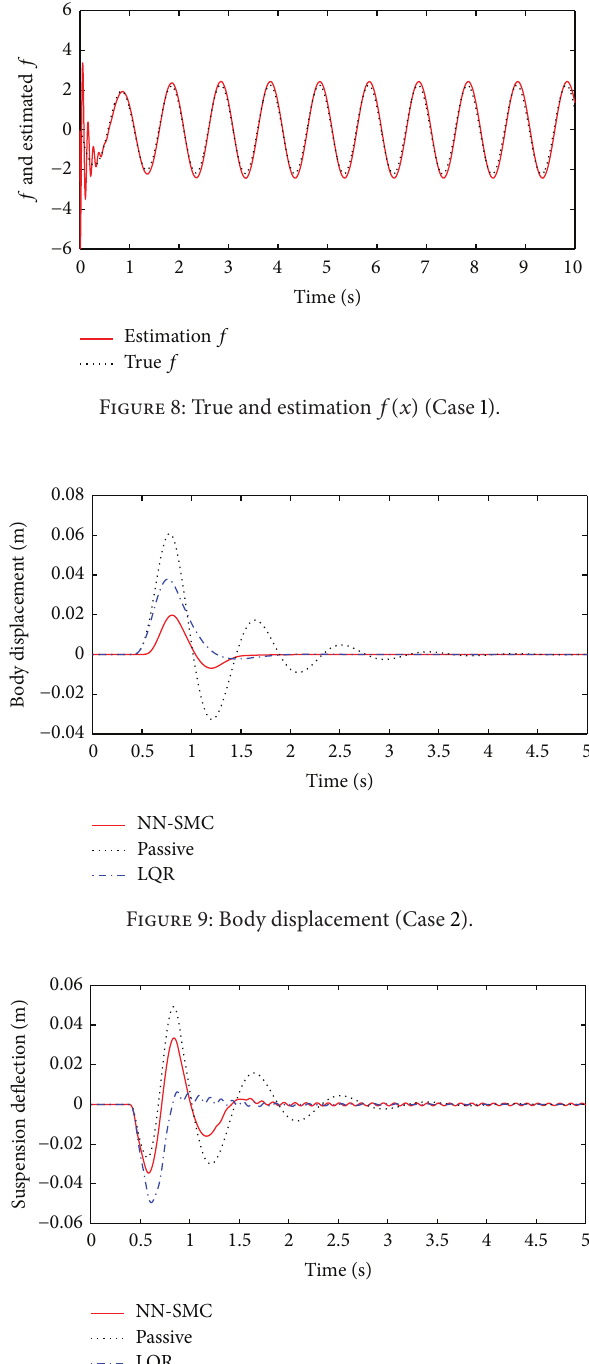
−4 −3 with NN-SMC is 3.33 × 10 , while the RMS value is 8.7 × 10 by LQR. As it appears in Figure 13, the fluctuation amplitude of the red line with NN-SMC is smaller than the blue dotted line. In Figure 14, the maximum value of body acceleration by NN-SMC is 0.65 m/s 2 , which is smaller than the maximum value under LQR method. But the root mean square